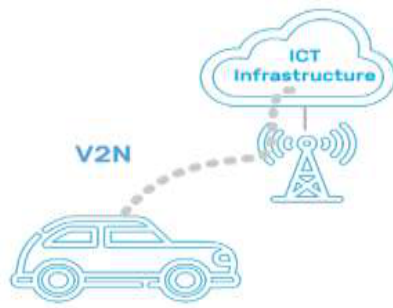
Figure 4. ©V2N communication Copyright 2017,